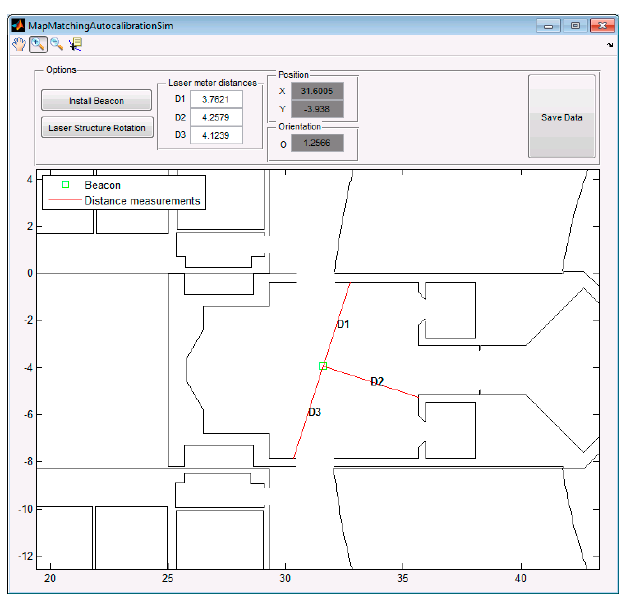
Figure 5. MatLab GUI that emulates the calibration system.